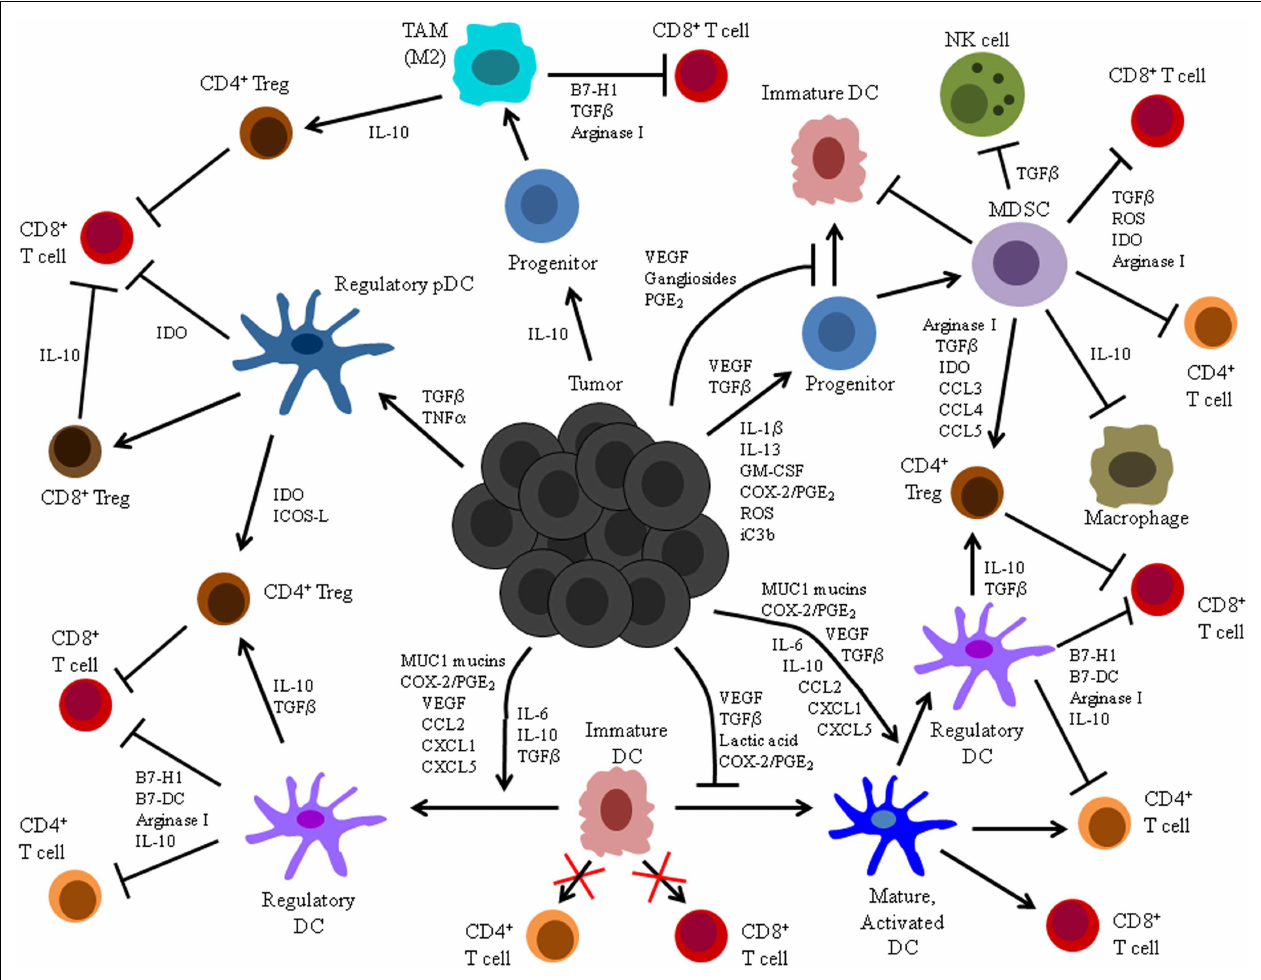
differentiation of DC precursors into immunosuppressive MDSC orTAM, (3) suppress maturation, activation, and stimulatory APC function of already differentiated DC, and (4) induce development of immunosuppressive regulatory